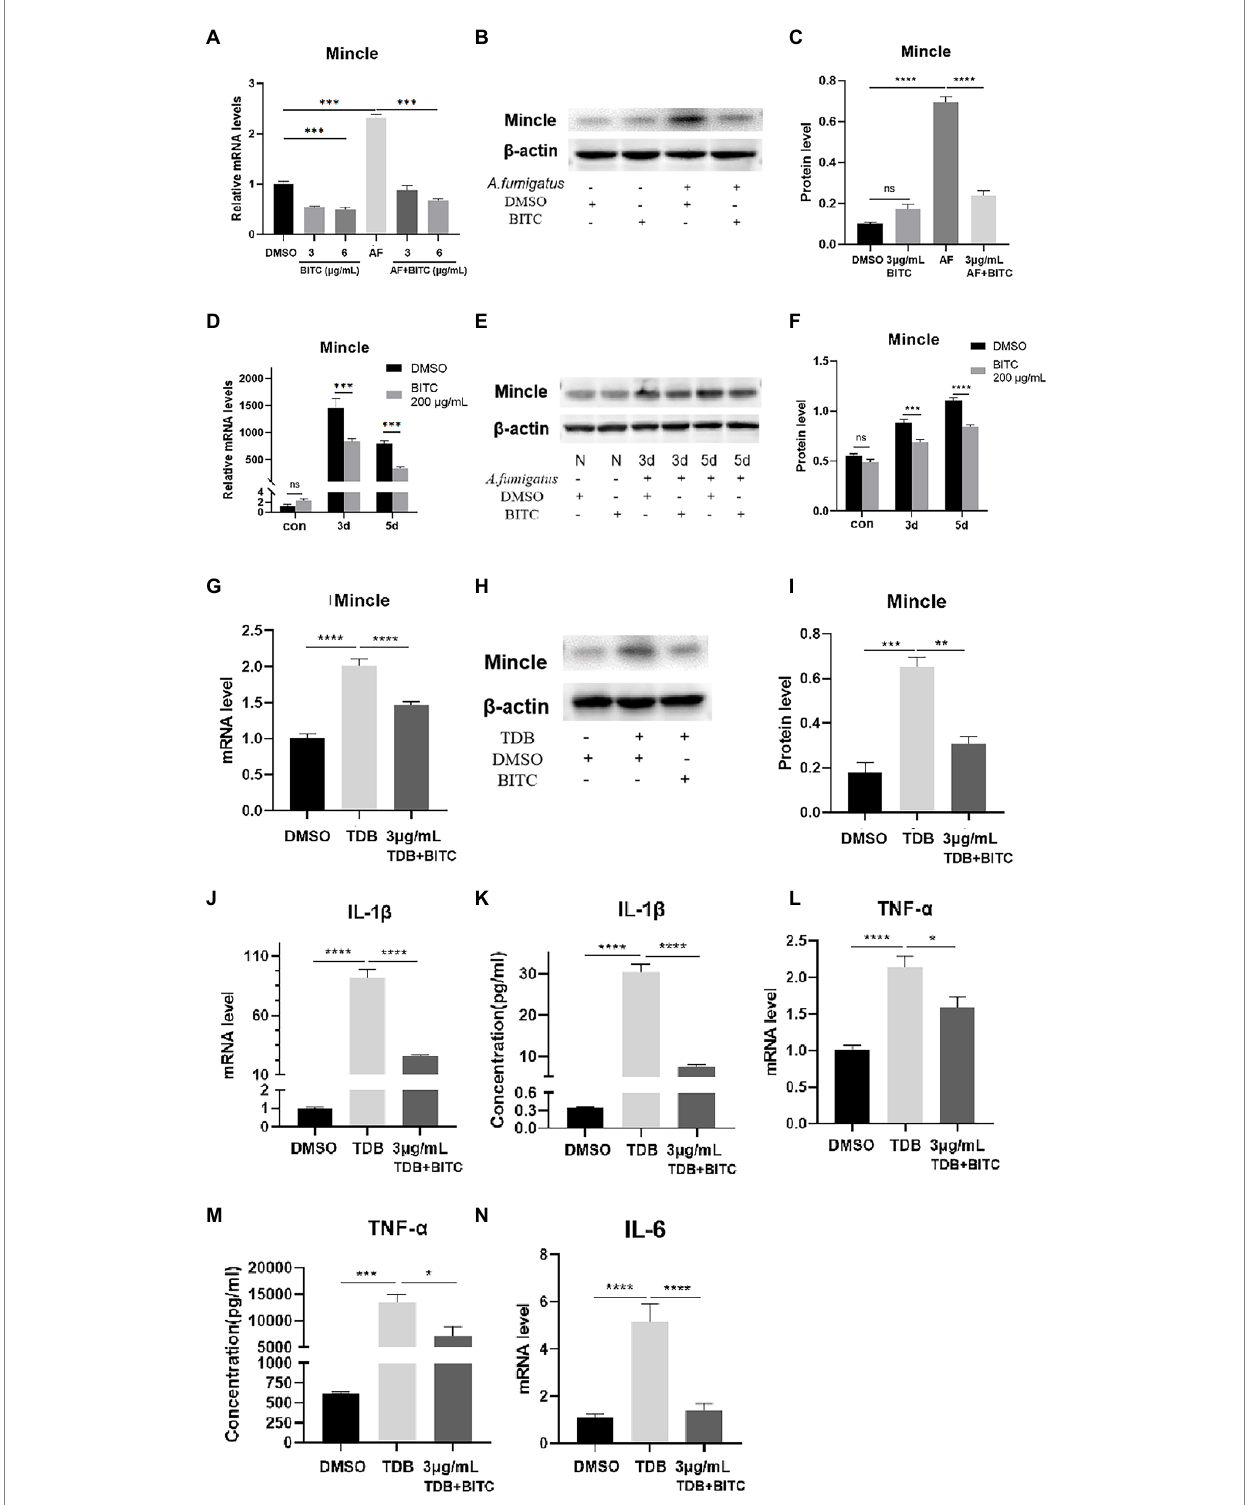
FIGURE 7 BITC downregulates Mincle to inhibit inflammatory response. The mRNA expression of Mincle ( A ) decreased after treatment of BITC (3 and 6 μ g/ml) in A. fumigatus stimulated RAW264.7 cells. Mincle protein level was also significantly repressed by BITC (3 μ g/ml) treatment ( B , C ) in RAW264.7 cells. Mincle mRNA expression ( D ) and protein expression ( E , F ) were decreased in BITC-treated (200 μ g/ml) corneas infected by A. fumigatus at 3 and 5 days p.i. The expression of Mincle mRNA ( G ) and protien ( H , I ) was decreased after treatment of BITC (3 μ g/ml) in TDB-stimulated RAW264.7 cells. Effects of BITC on TDB-stimulated RAW264.7 cells RT-PCR and ELISA results for IL-1 β ( J , K ), TNF- α ( L , M ), and IL-6 ( N ) in TDB-stimulated RAW264.7 cells treated with BITC (3 μ g/ml) or 0.1% DMSO. Values represent as means ± SD (* p < 0.05, ** p < 0.01, *** p < 0.001, **** p <